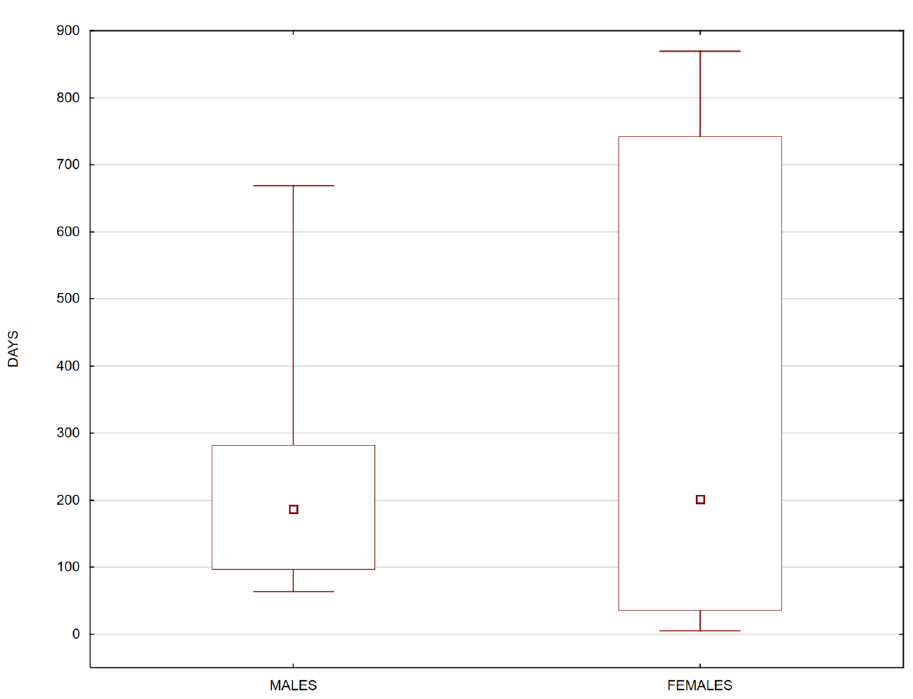
Figure 2. Box-and-whisker plots of male and female (N = 15) life expectancy, expressed as the number of days from the date of release to the date of confirmed death in the wild (the square inside each box indicates the median value, the edges of the box are the 25th and 75th percentiles, and the whiskers extend to the most extreme